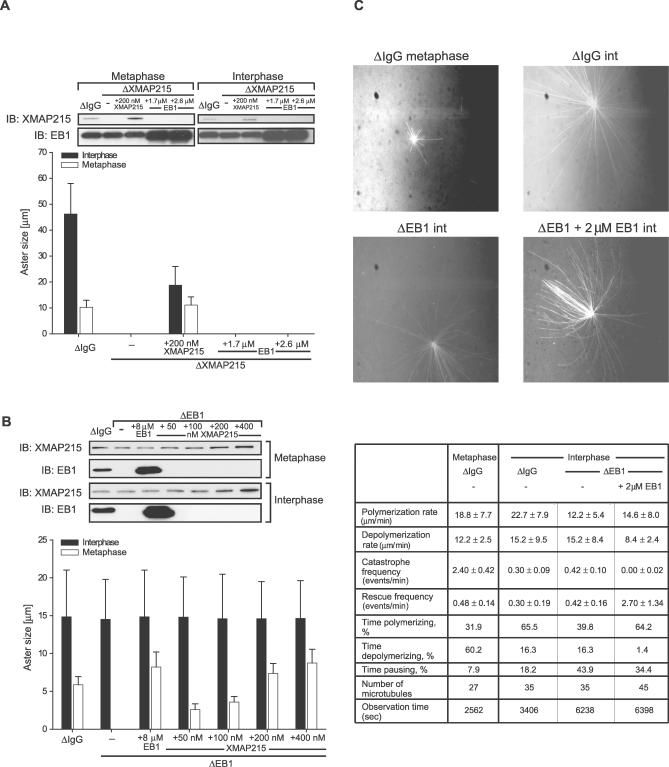
MT Stabilizing Activities of EB1 and XMAP215 in Interphase and Metaphase Xenopus Egg Extracts(A) Average size of asters in response to depletion of XMAP215 (ΔXMAP215) from the extract and the addition of recombinant EB1 to the ΔXMAP215 extract. Error bars represent the S.D. (n > 30). Upper panel: immunoblot (IB) of MAPs after indicated treatments.(B) Average size of asters in response to depletion of EB1 (ΔEB1) from the extract and the addition of recombinant XMAP215 to the ΔEB1 extract. Error bars represent the S.D. (n > 30). Upper panel shows the immunoblot (IB) of MAPs after the indicated treatments.(C) Still images of MT asters after the indicated treatments are shown in the upper panel. Table summarizing the dynamic parameters of MT growth in response to EB1 depletion (ΔEB1) and add back of recombinant EB1 into ΔEB1 interphase extracts is shown in the lower panel.